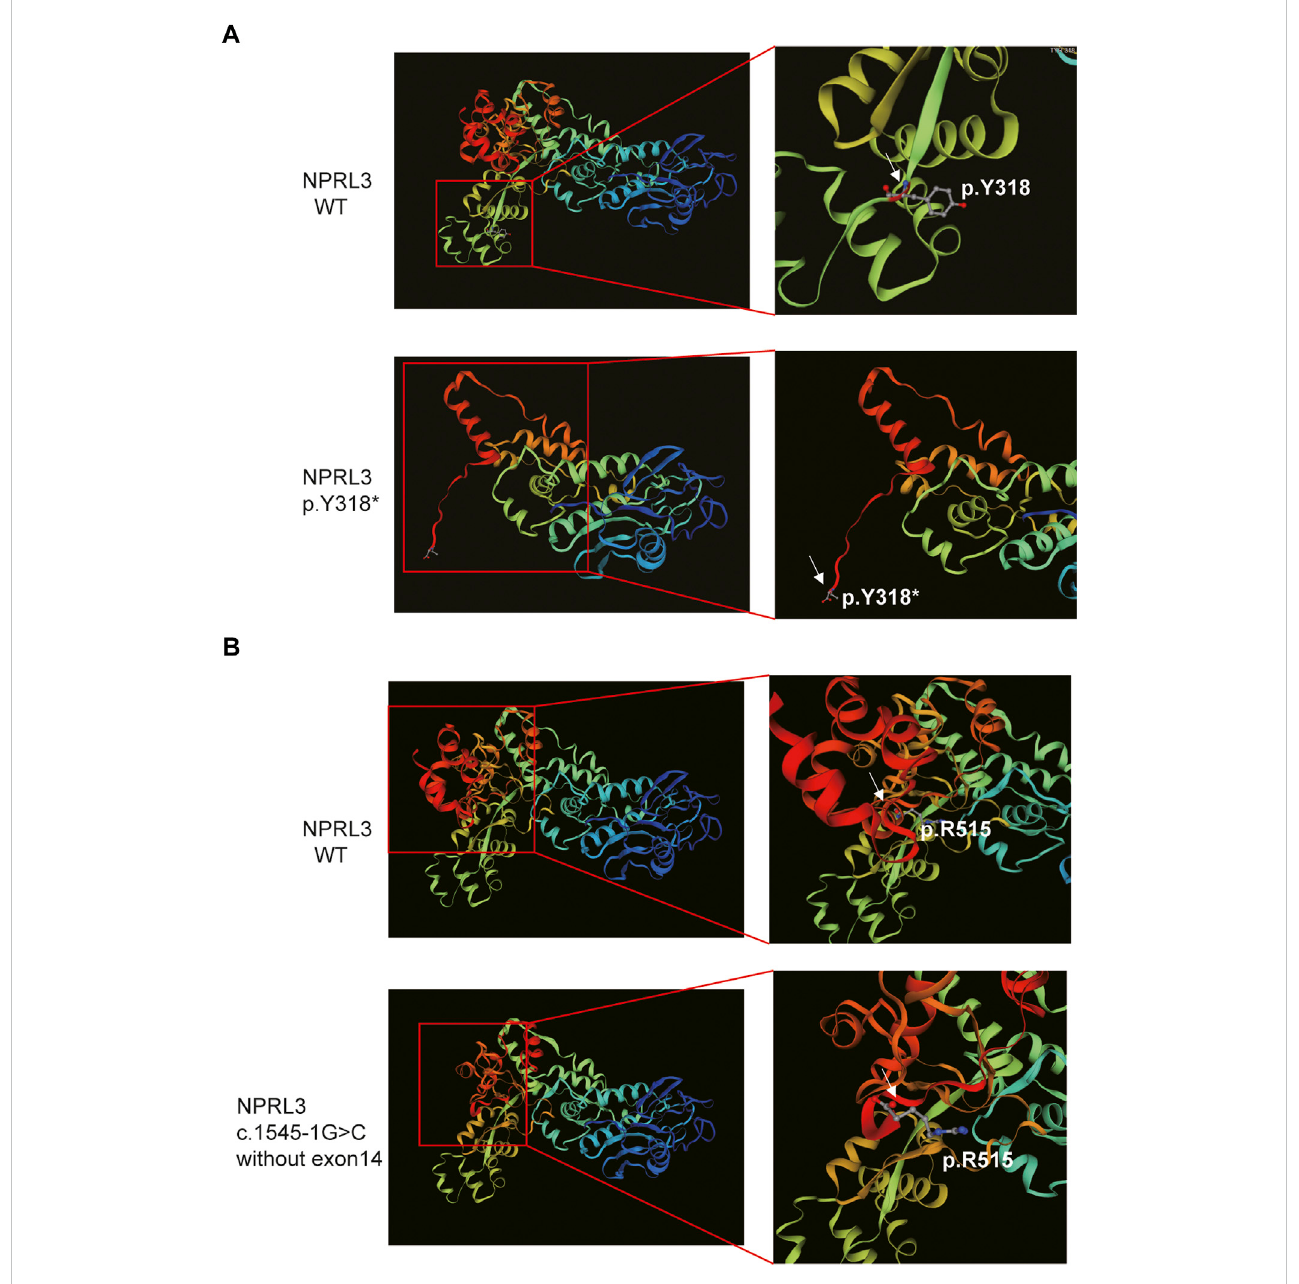
FIGURE 4 The 3D modeling of the wild-type and variant protein indicated different structures (visualized by SWISS-MODEL). (A) Comparison of wild-type and p.Y318* predicted structure. Left panel: Overall 3D modeling of wild-type and variant proteins. Right panel: Partial magni fi cation of 3D models of wild-type and variant proteins. White arrow indicated the position of the p.Y318. (B) The 3D modeling of the wild-type and the mutant protein without exon 14. Left panel: Overall 3D modeling of wild-type and variant proteins. Right panel: Partial magni fi cation of 3D models of wild-type and variant proteins. White arrow indicated the position of the last amino acid of the mutant